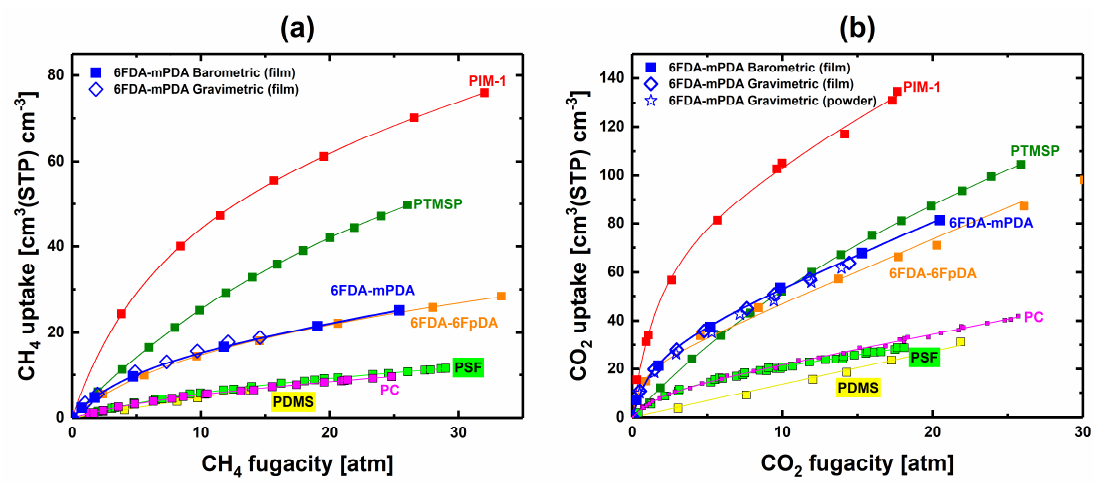
Figure 3. ( a ) CH 4 and ( b ) CO 2 pure-gas sorption isotherms at 35 °C vs. gas fugacity. Blue squares were obtained with 6FDA-mPDA films in our custom-built barometric system. Blue diamonds were obtained with 6FDA-mPDA films via gravimetric sorption. CO 2 pure-gas gravimetric